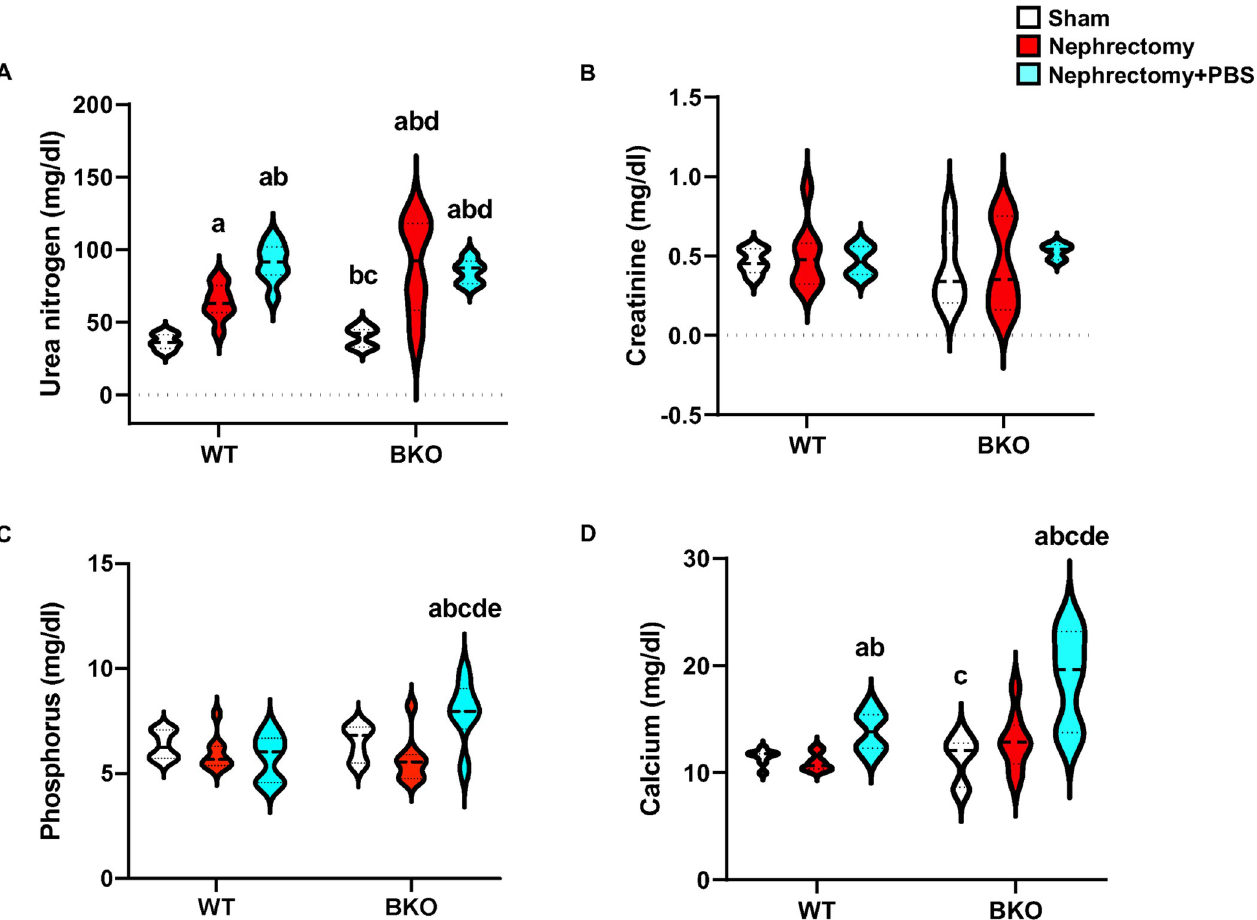
Fig 2. Nephrectomy increases serum urea nitrogen and high phosphate enhances serum phosphorus and calcium in nephrectomized BKO mice. (A) Serum urea nitrogen from sham WT (n = 8), nephrectomized WT (n = 8), nephrectomized WT+PBS (n = 8), sham BKO (n = 7), nephrectomized BKO (n = 8), and nephrectomized BKO+PBS mice (n = 5). (B) Serum creatinine from sham WT (n = 5), nephrectomized WT (n = 8), nephrectomized WT+PBS (n = 4), sham BKO (n = 6), nephrectomized BKO (n = 8), and nephrectomized BKO+PBS mice (n = 3). (C) Serum phosphorus from sham WT (n = 8), nephrectomized WT (n = 8), nephrectomized WT+PBS (n = 8), sham BKO (n = 7), nephrectomized BKO (n = 8), and nephrectomized BKO+PBS mice (n = 6). (D) Serum calcium from sham WT (n = 8), nephrectomized WT (n = 8), nephrectomized WT+PBS (n = 8), sham BKO (n = 7), nephrectomized BKO (n = 8), and nephrectomized BKO+PBS mice (n = 6). a p < 0.05 versus sham WT, b p < 0.05 versus nephrectomized WT, c p < 0.05 versus nephrectomized WT +PBS, d p < 0.05 versus sham BKO, and e p < 0.05 versus nephrectomized BKO.